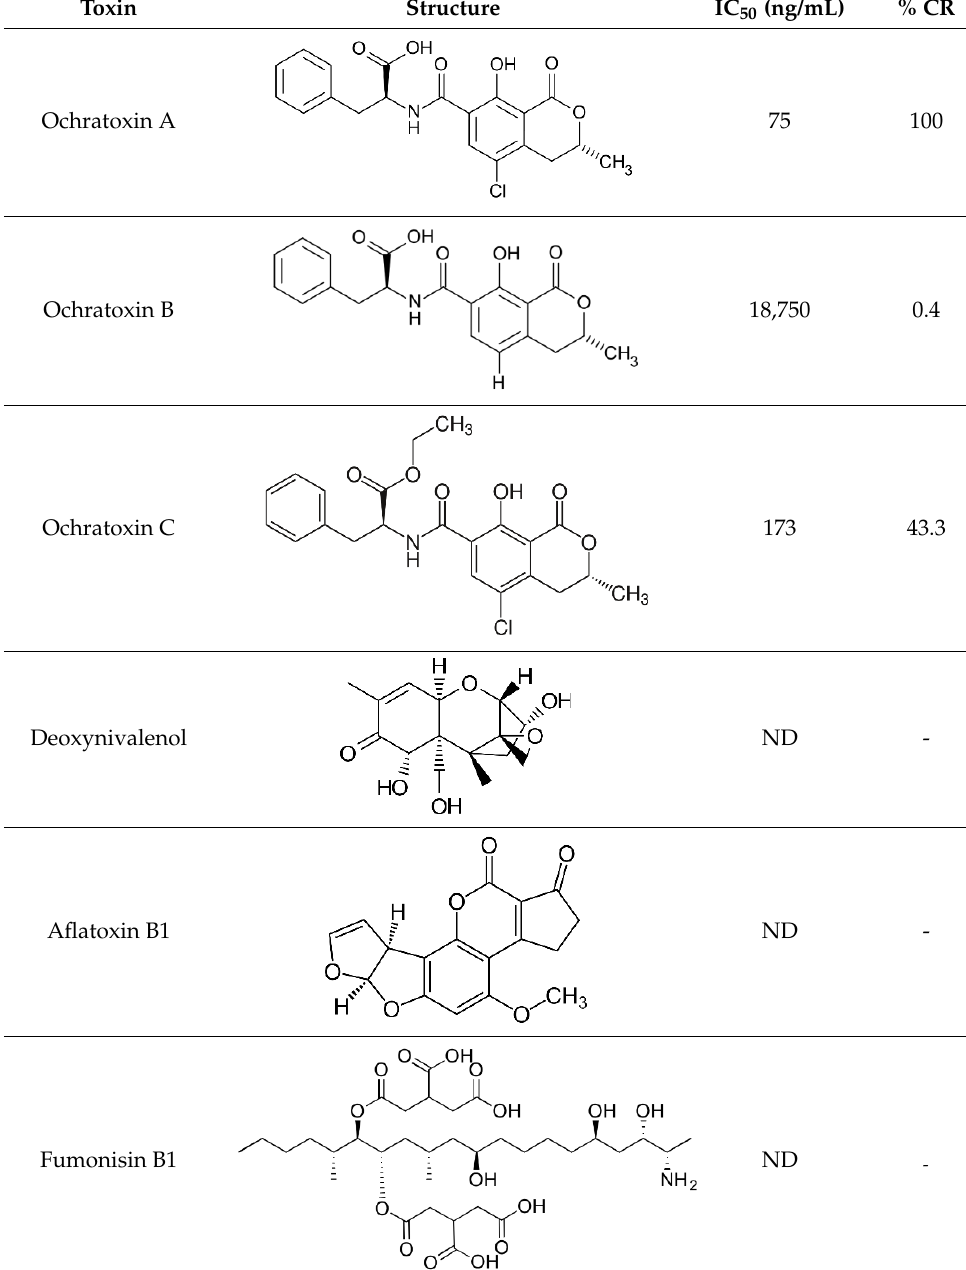
Table 1. Cross reactivity shown by structurally related- and unrelated-to-OTA toxins. Toxin Structure